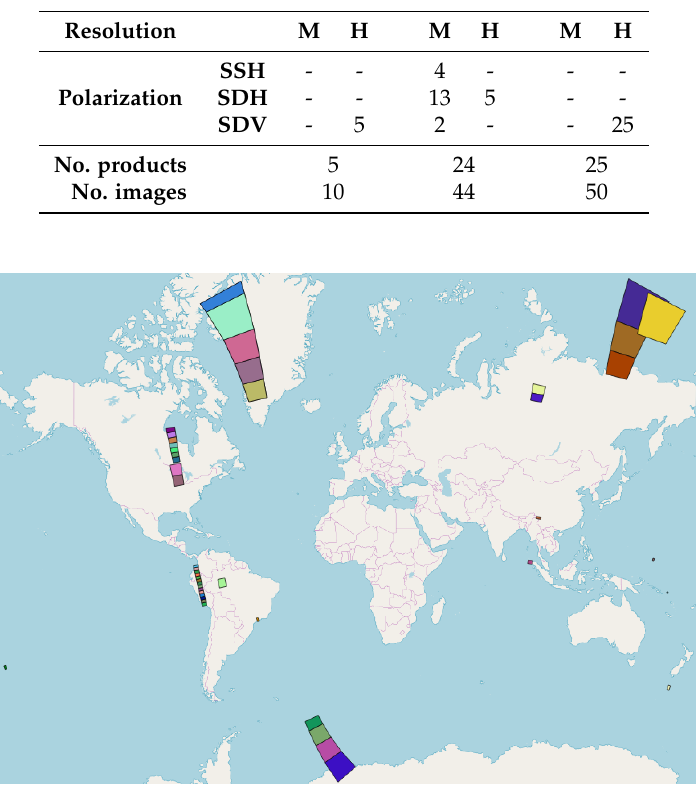
Figure 4. Footprints of the Sentinel-1 products selected for the performance assessment. Base layer c (cid:13) OpenStreetMap contributors